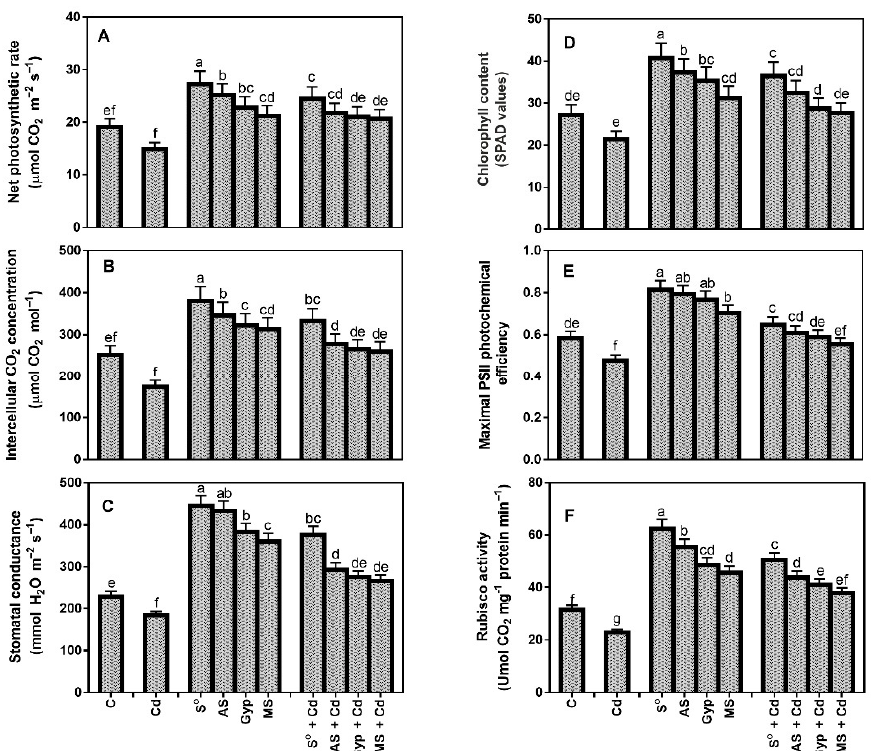
Figure 3. ( A ) Net photosynthesis, ( B ) intercellular CO 2 concentration, ( C ) chlorophyll content (SPAD values), ( D ) stomatal conductance, ( E ) maximal PSII photochemical efficiency ( F v /F m ), and ( F ) Rubisco activity in leaves of Brassica juncea cv. Giriraj treated with 200 mg S kg − 1 soil of elemental S (S 0 ), ammonium sulfate (AS), gypsum (Gyp), or magnesium sulfate (MS), grown with or without cadmium (200 mg Cd kg − 1 soil). Data are presented as means ± SE ( n = 4). Data with the same letter are not significantly different by LSD test at p < 0.05. C, control; Cd, cadmium; Rubisco, ribulose-1,5-bisphosphate carboxylase/oxygenase.